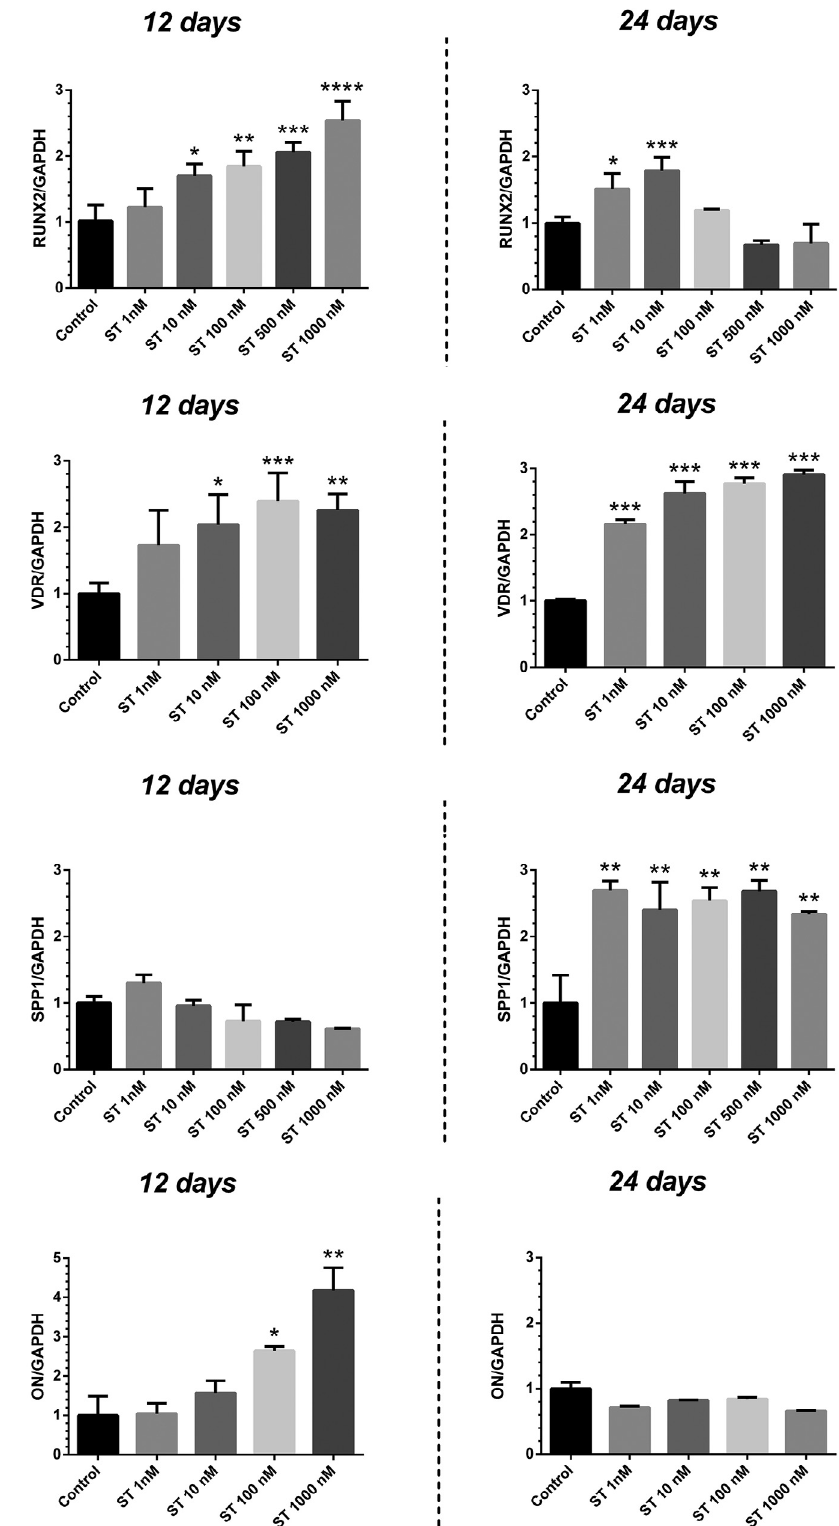
Figure 5- Gene expression of SaOS-2 treated with different concentrations (0-1000 nM) of stanozolol (ST) at 12 and 24 days observation period; (a) RUNX2: runt-related transcription factor 2; (b) VDR: Vitamin D Receptor; (c) SPP1: Osteopontin; (d) ON: Osteonectin. Data are reported as fold change over 0 nM ST and are expressed as mean ± standard deviation. Asterisks indicate statistical significance (*: p<0.05 vs control; ** p<0.005 vs control; ***: p<001 vs